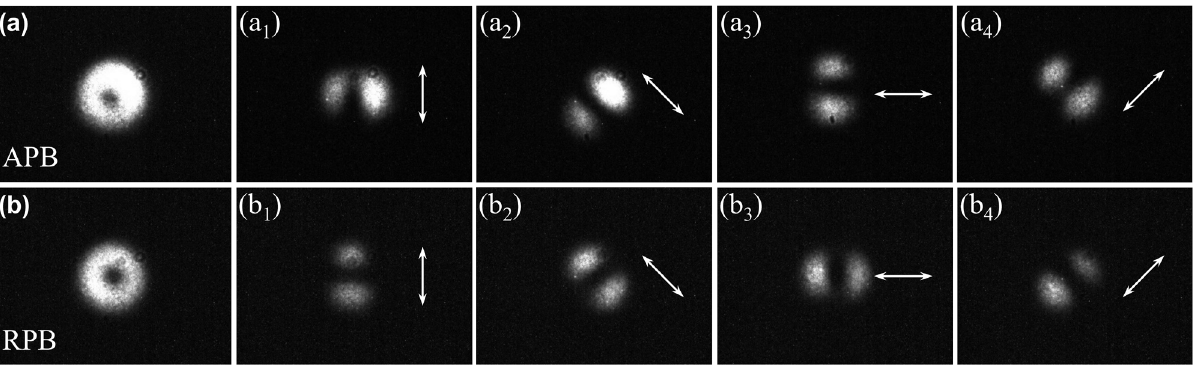
parallel/perpendicular to the transmission axis of the polar- izer, indicating that the output laser beam is APB/RPB.